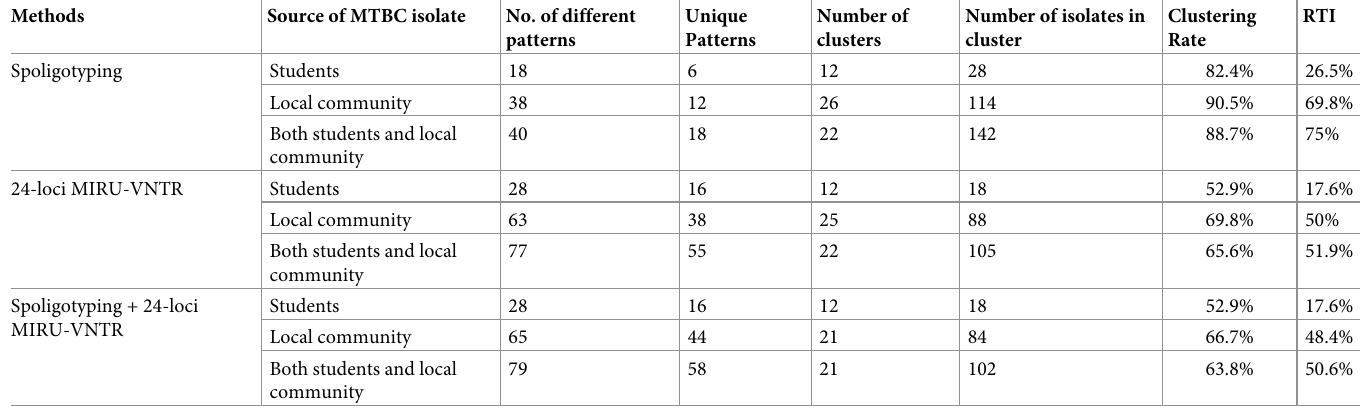
Table 3. Clustering rate and Recent Transmission Index (RTI) analysis using Spoligotyping and MIRU-VNTR 24-loci methods for local community, university stu- dents and all study participants, Eastern